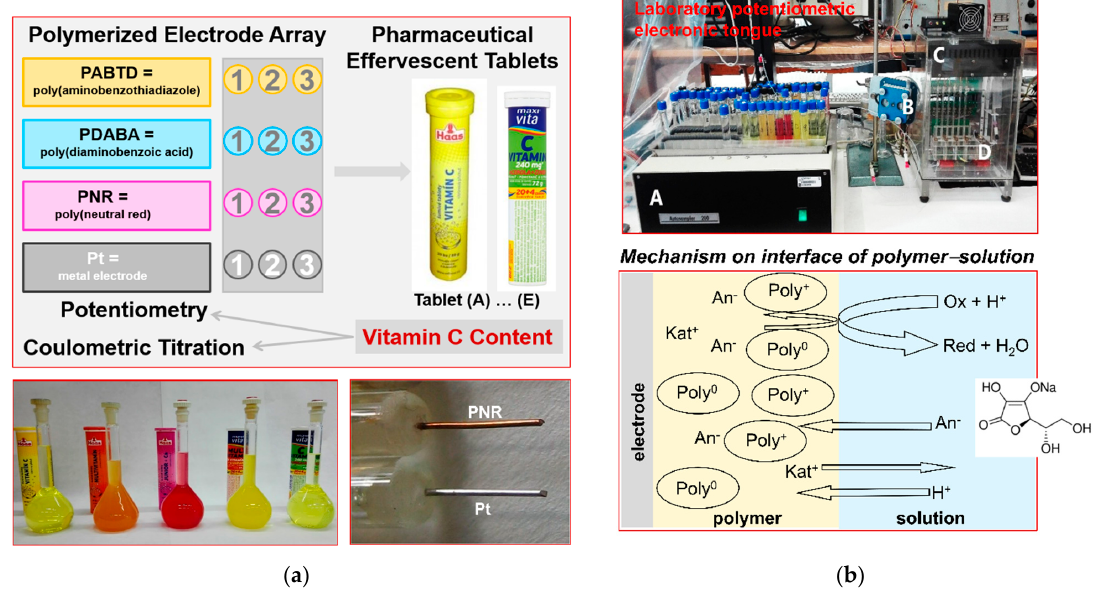
Figure 1. Potentiometric electronic tongue ( a ) concept for discrimination of sample of effervescent tablets containing vitamin C; ( b ) laboratory ET setup (automatic sample feeder (A) connected with a pump (B) and a thermostatically controlled box (C), in which the cell (D) with electrodes is located) and schema of possible mechanism of electrode response [23,24].